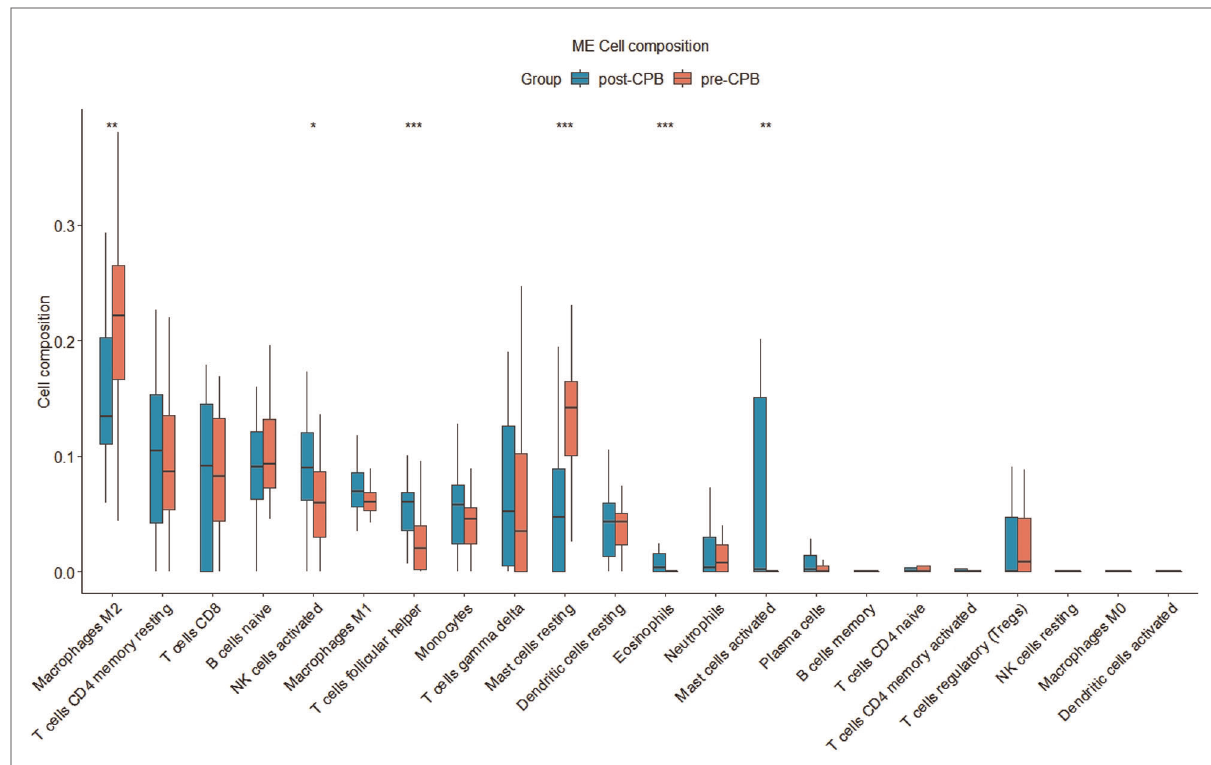
FIGURE 10 Immune in fi ltration analysis plot. There was a signi fi cant change in macrophages M2 ( P <0.01), mast cells resting ( P <0.001), NK cells activated ( P < 0.05), T cells follicular helper ( P <0.001), mast cells activated ( P <0.01) and eosinophils ( P <0.001) in the post-CPB group compared to the pre-CPB group. “ * ” , “ ** ” , “ *** ” represent P <0.05, P <0.01, P <0.001,